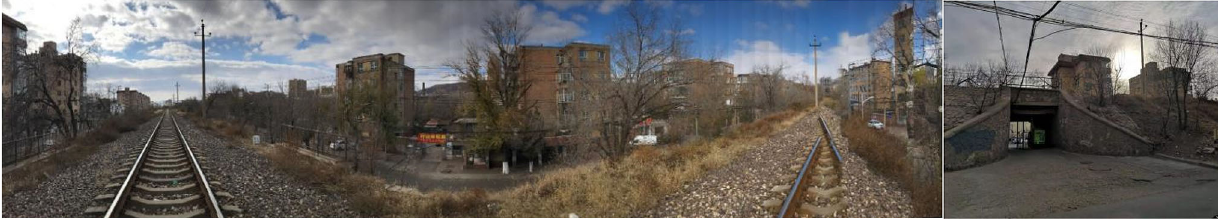
Fig. 4 Environment along the abandoned railway. Source : Drawn by the